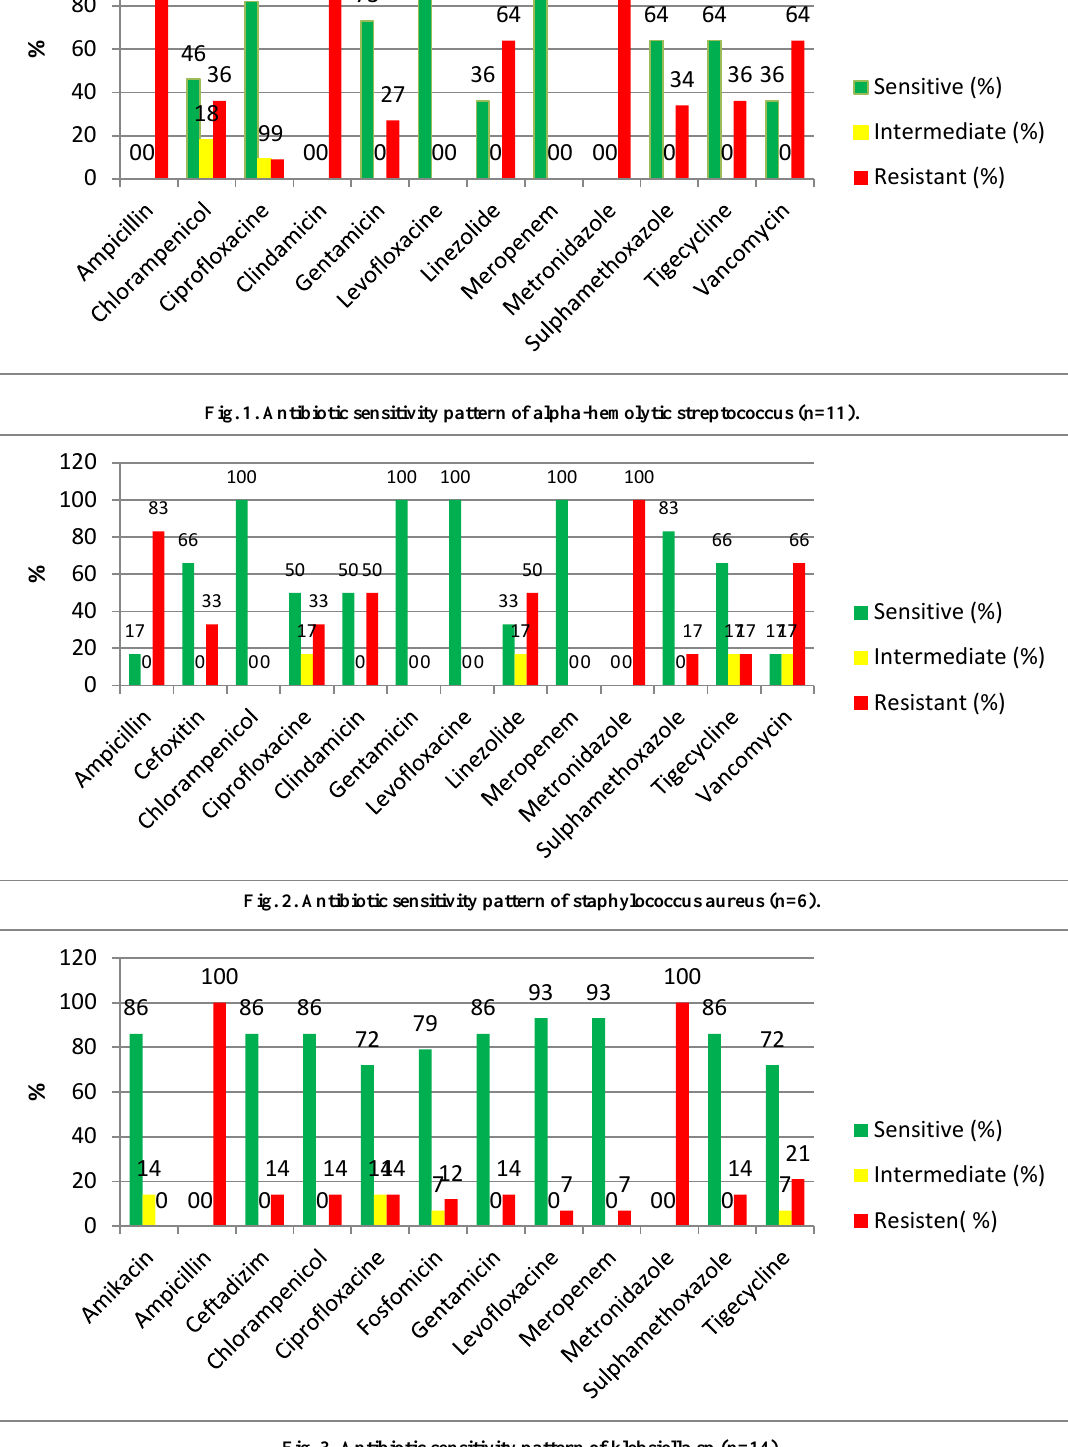
Fig. 3. Antibiotic sensitivity pattern of klebsiella sp